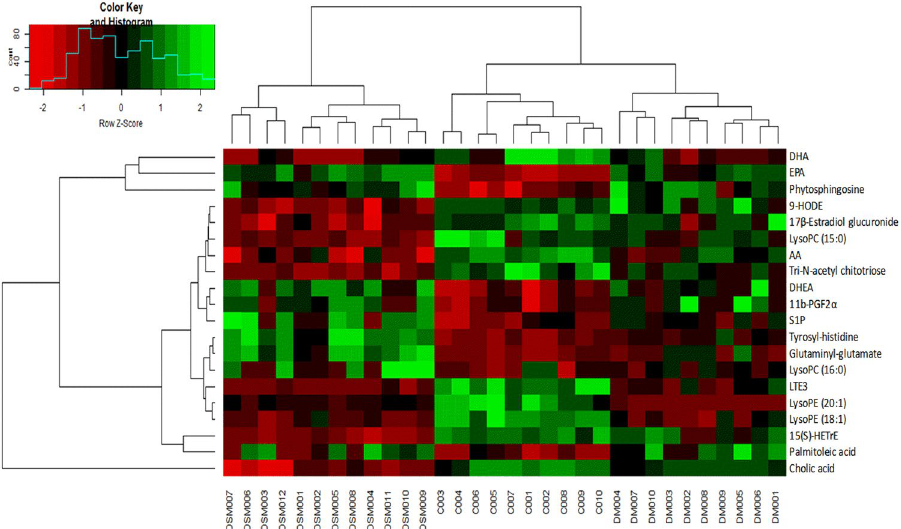
Figure 6. Heatmap of 20 potential biomarkers between control and model groups. The color of each section is proportional to the significance of change of metabolites (red, upregulated; green, downregulated)as the numbers listed in Table 2. Rows: metabolites; Columns: samples (C: control group; DM: disease model group; DSM: DS model group).